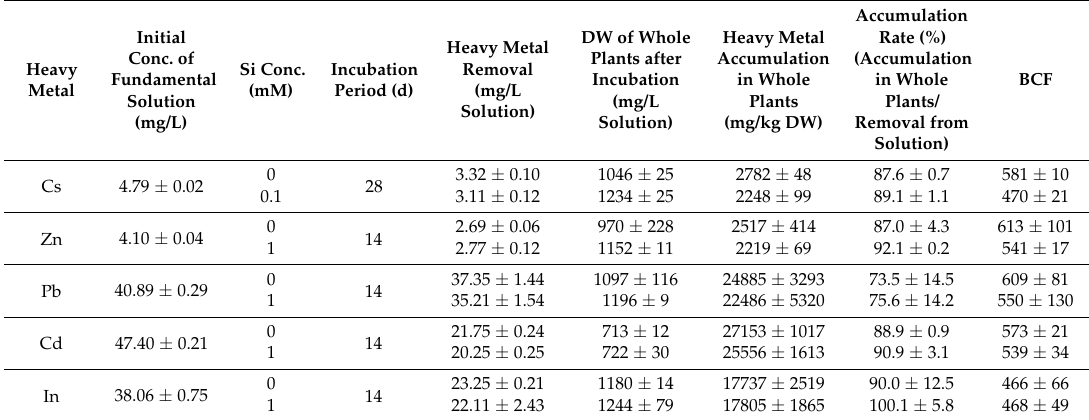
Table 1. Summary of the removal of heavy metals and accumulation in E. acicularis subcultured with or without Si. BCF, bioconcentration factor.